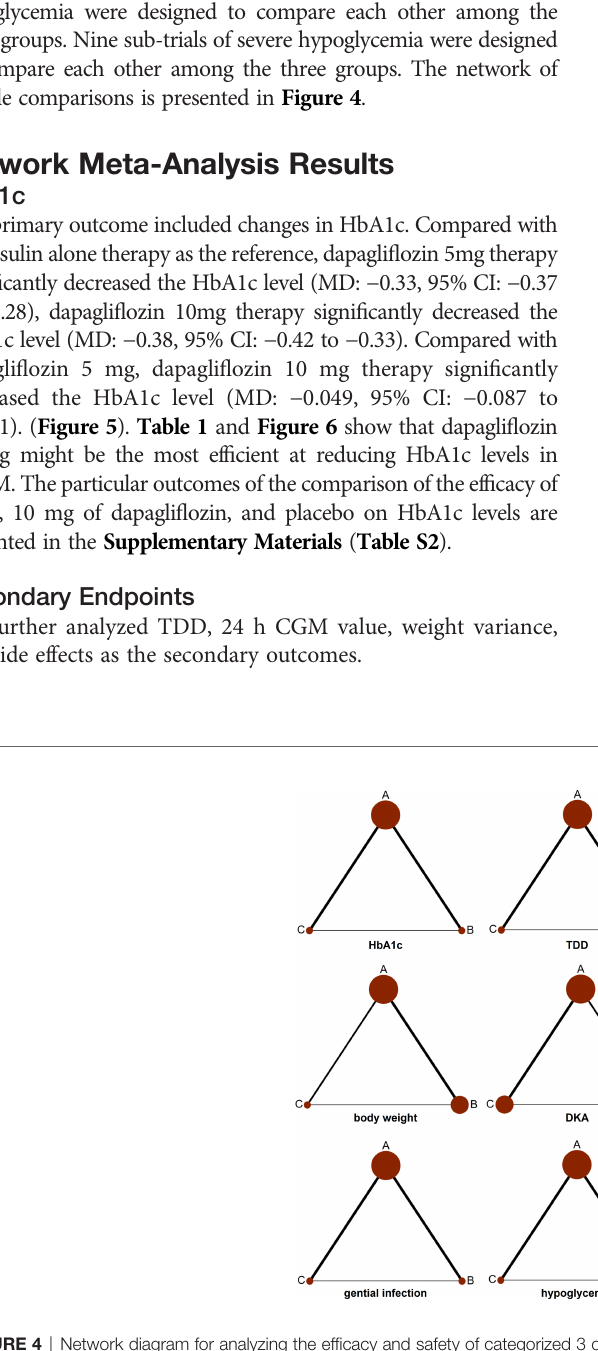
FIGURE 4 | Network diagram for analyzing the ef fi cacy and safety of categorized 3 different interventions. The width of the lines presents the whole number of trials for every comparison, and the size of every node is proportional to the number of randomized participants (sample size). (A) dapagli fl ozin 5 mg + insulin, (B) dapagli fl ozin 10 mg + insulin, and (C) placebo +